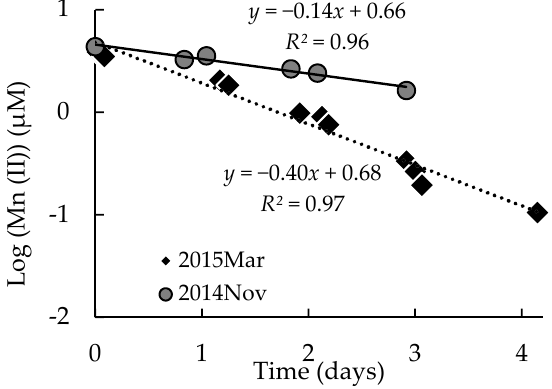
Figure 3. Soluble Mn removal from the raw water during storage.